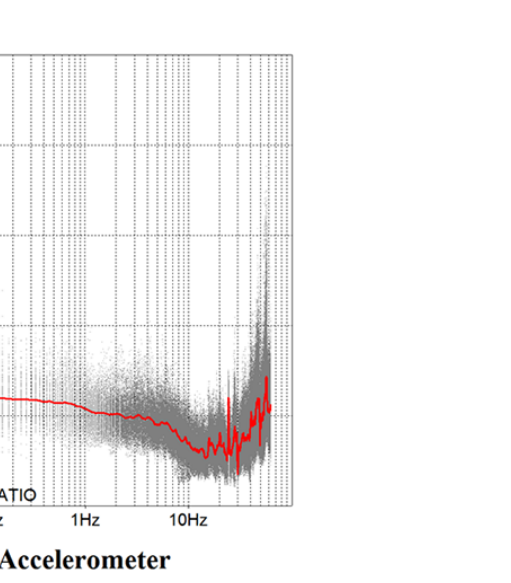
Figure 5. Data of Guralp velocimeter (left graph) and REFTEK accelerometer 130-SMA (right graph), analysed with HVSR technique for a recording of 60min length on the ground floor of the old building of TEI Chania.